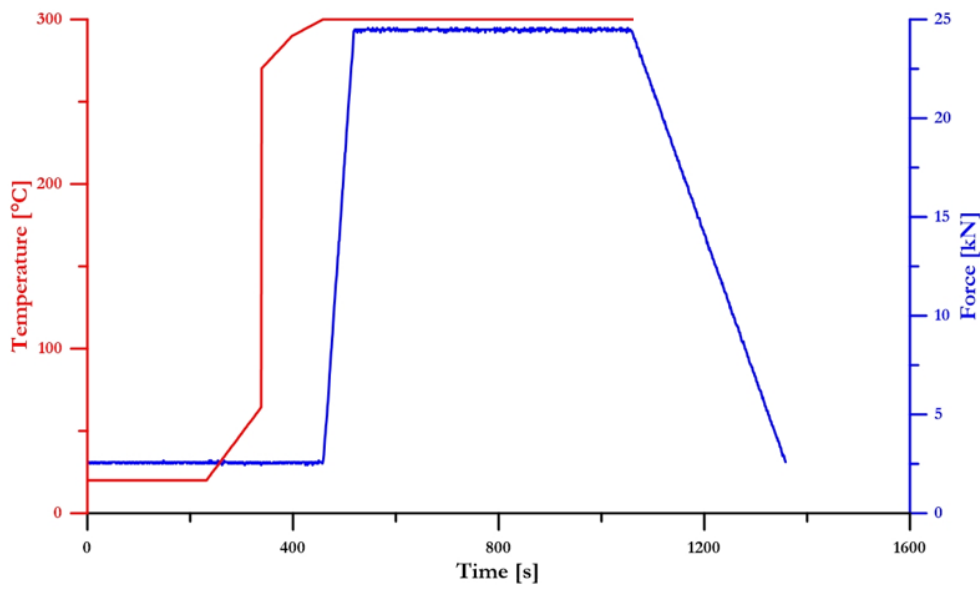
Figure 1. Time profiles of the SPS process conditions.